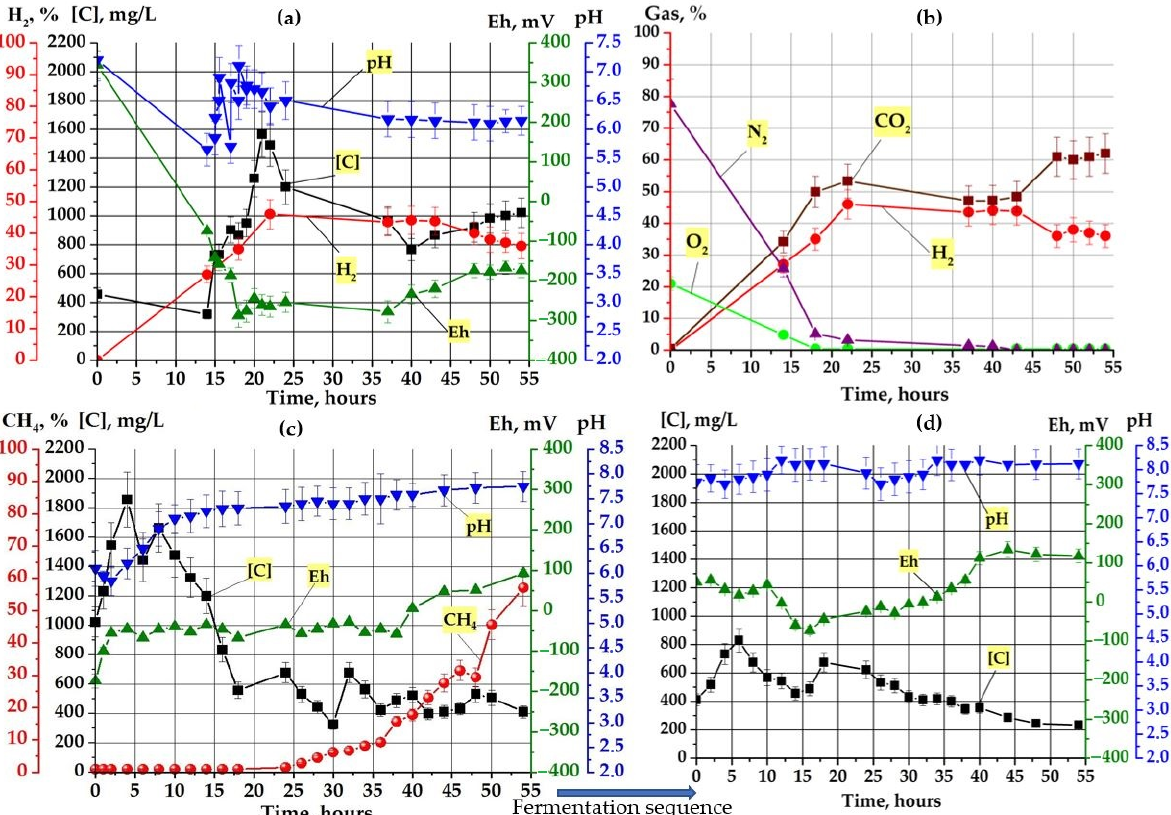
Figure 4. The dynamics of metabolic parameters and gas composition during the fermentation of multicomponent food waste in the hydrogen bioreactor ( a , b ) and subsequent anaerobic degradation of fatty acids and alcohols in the two-module methane tank ( c , d ). The concentration of H 2 and CH 4 is shown by red lines. Green lines represent the redox potential, while the total carbon concentration is shown in black. The blue and green lines correspond to pH and O 2 concentration, while fluctuations in levels of N 2 and CO 2 are shown in brown and purple colors, respectively. Data points and error bars represent mean values ( n = 3) and standard deviations.